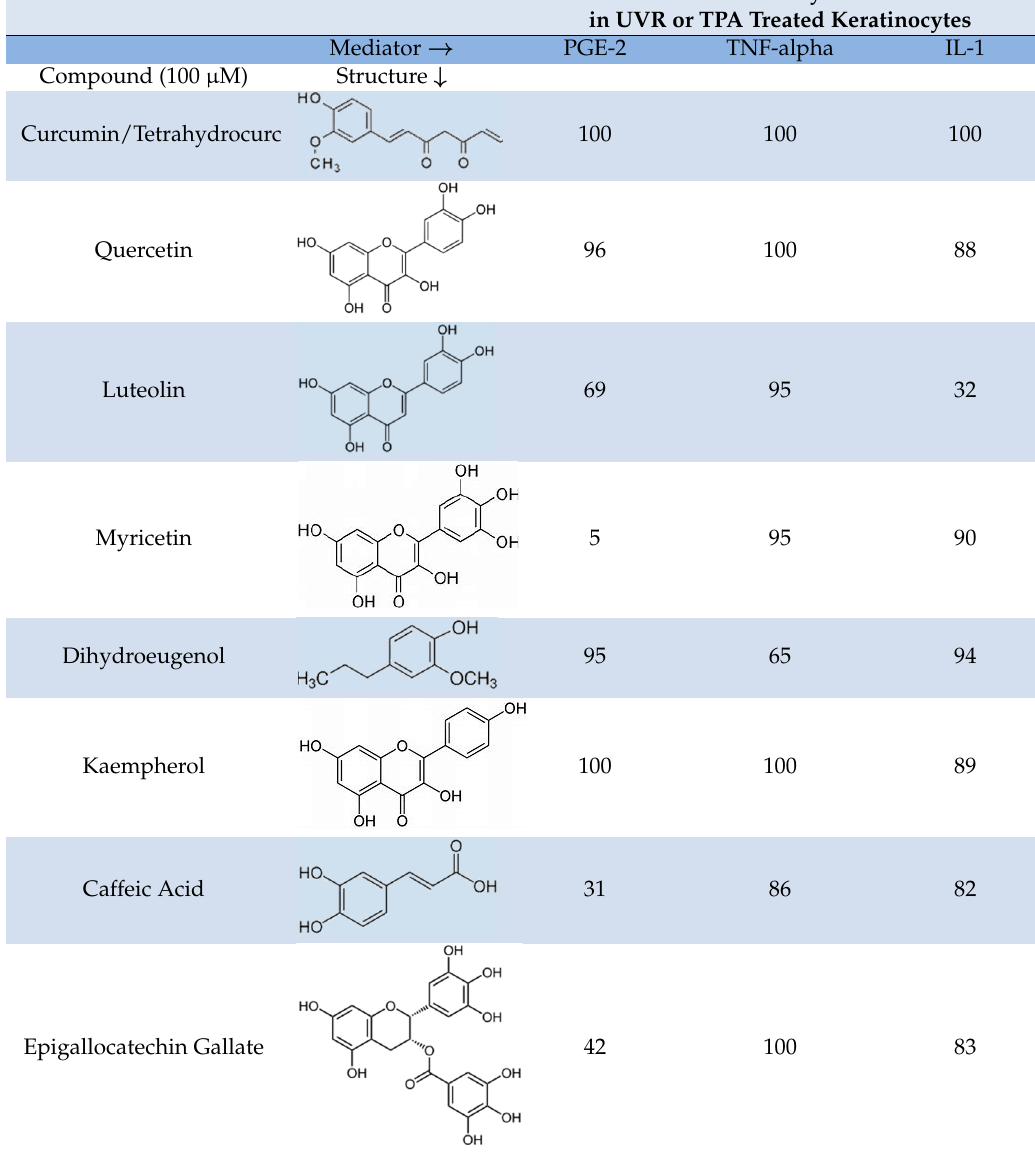
Table 2. Anti-inflammatory effects of natural phenolic compounds. Human keratinocyte cells were seeded into 12 well culture dishes and allowed to attach overnight. For irradiation experiments cultures irradiated with 50 mJ of UVB radiation, and fresh medium added that contained either the compound under investigation (100 µ M) or the solvent for the compound used as vehicle control. After 24 h, medium was removed and assayed by commercial ELISA assay kits for either PGE-2, TNF-alpha, or IL-1. For experiments with TPA cells were treated with TPA (phorbol 12-myristate 13-acetate, 20 ng/mL), or 0.2% DMSO as a control After 24 h medium was removed and assayed by ELISA for PGE-2, TNF-alpha or IL-1.